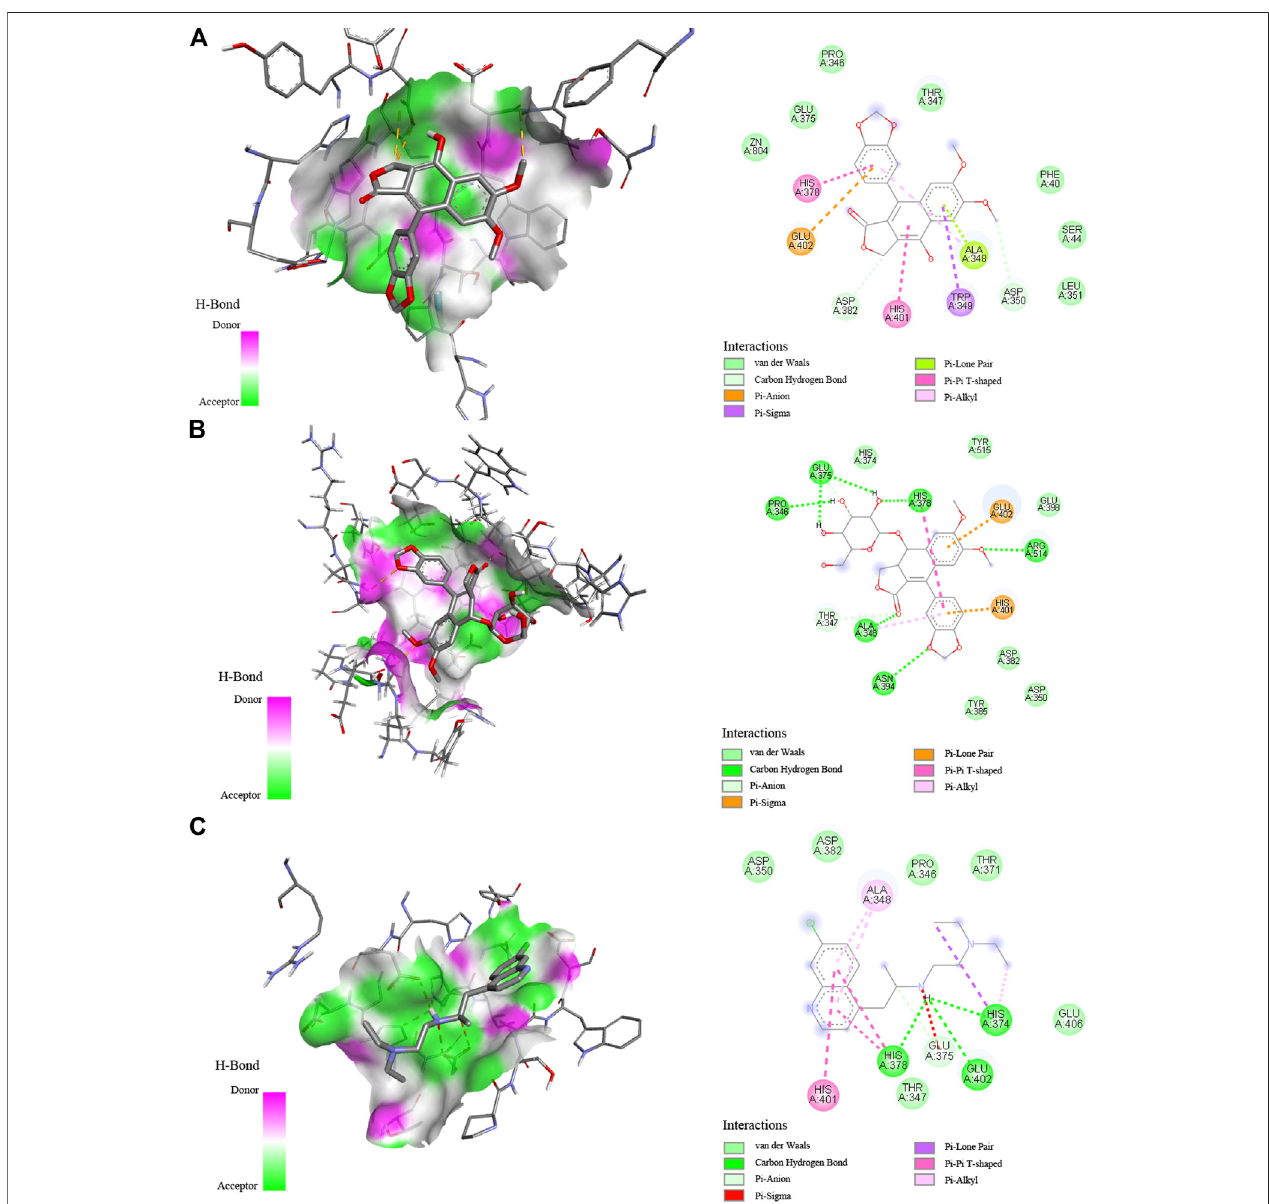
FIGURE 5 | Interaction between ACE2 and diphyllin (A) , diphyllin O -glucoside (B) , or chloroquine (C) by molecular docking analysis.